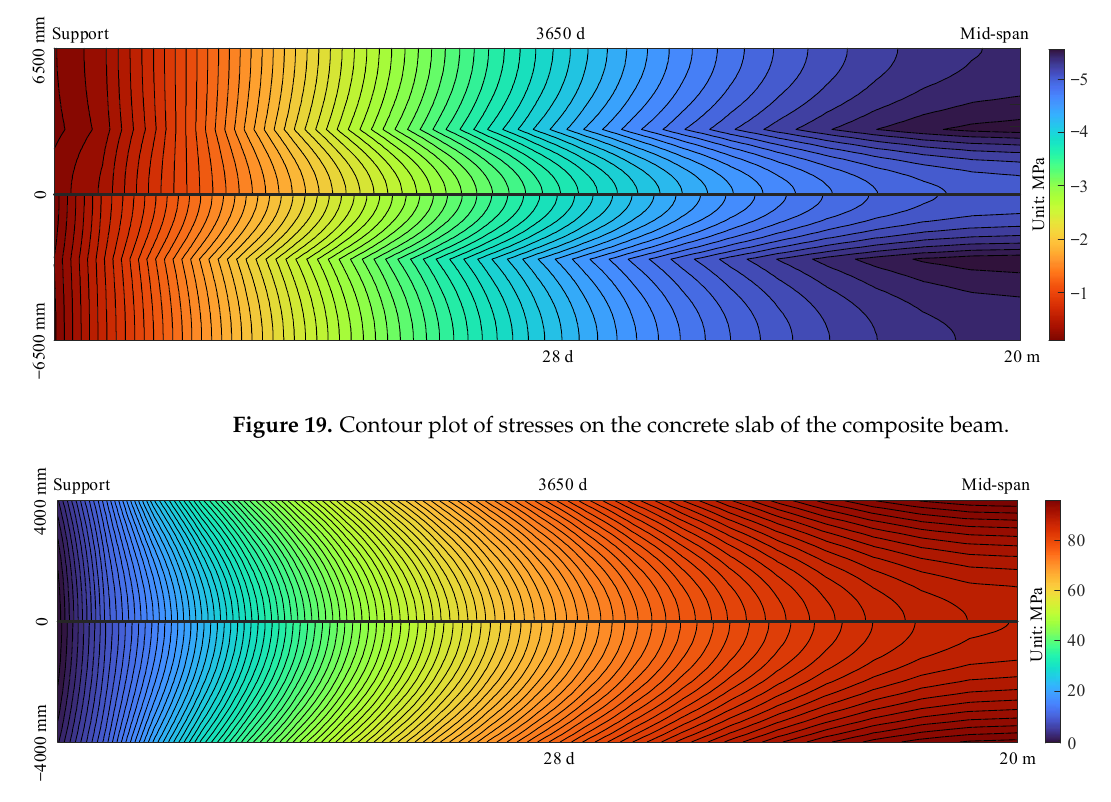
Figure 20. Contour plot of stresses at the bottom flange of the steel beam of the composite beam.